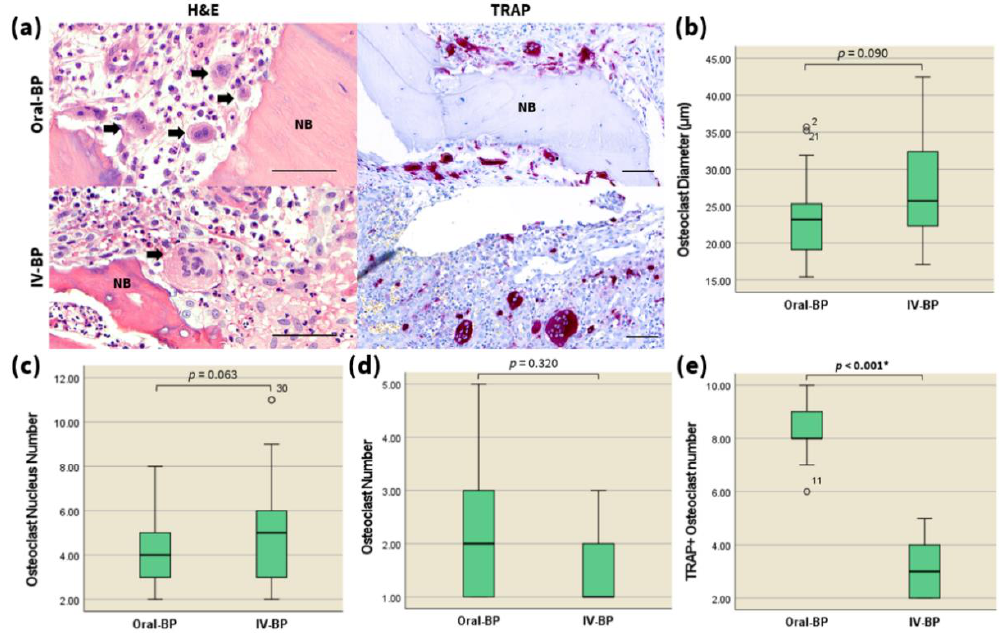
Figure 1. ( a ) High-magnification images (800x) of H&E (left) and TRAP (right) staining exhibiting round-shaped, multi- nucleated, giant osteoclasts (black arrows) at the necrotic jaw bone samples retrieved from IV-BP and oral-BP induced MRONJ subjects. Scale bars = 50 µ m. Statistical analysis of the mean osteoclast diameter ( b ), number of nuclei ( c ), total osteoclast number ( d ), and TRAP-positive osteoclasts ( e ) in the necrotic bone specimen from ( a ), via the Mann–Whitney U test ( n = 20 per group). ◦ marks statistical outliers. For detailed data, see Table 2. NB, necrotic bone; BP, bisphosphonates; IV, intravenous. * p < Table 2. H&E, TRAP, and IHC analysis of the specimens retrieved from the Oral-BP, IV-BP groups.